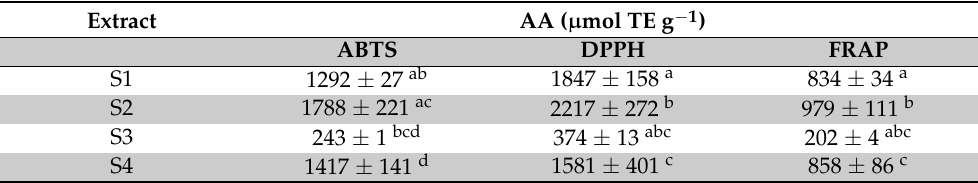
Table 3. Antioxidant activities (AA) of E. arvense L. extracts by ABTS, DPPH, and FRAP assays. The results are expressed as mean ± SD from 3 independent measurements in each case. Values in each column that share the same letter differ from each other (Mann–Whitney u-test, p < 0.05).